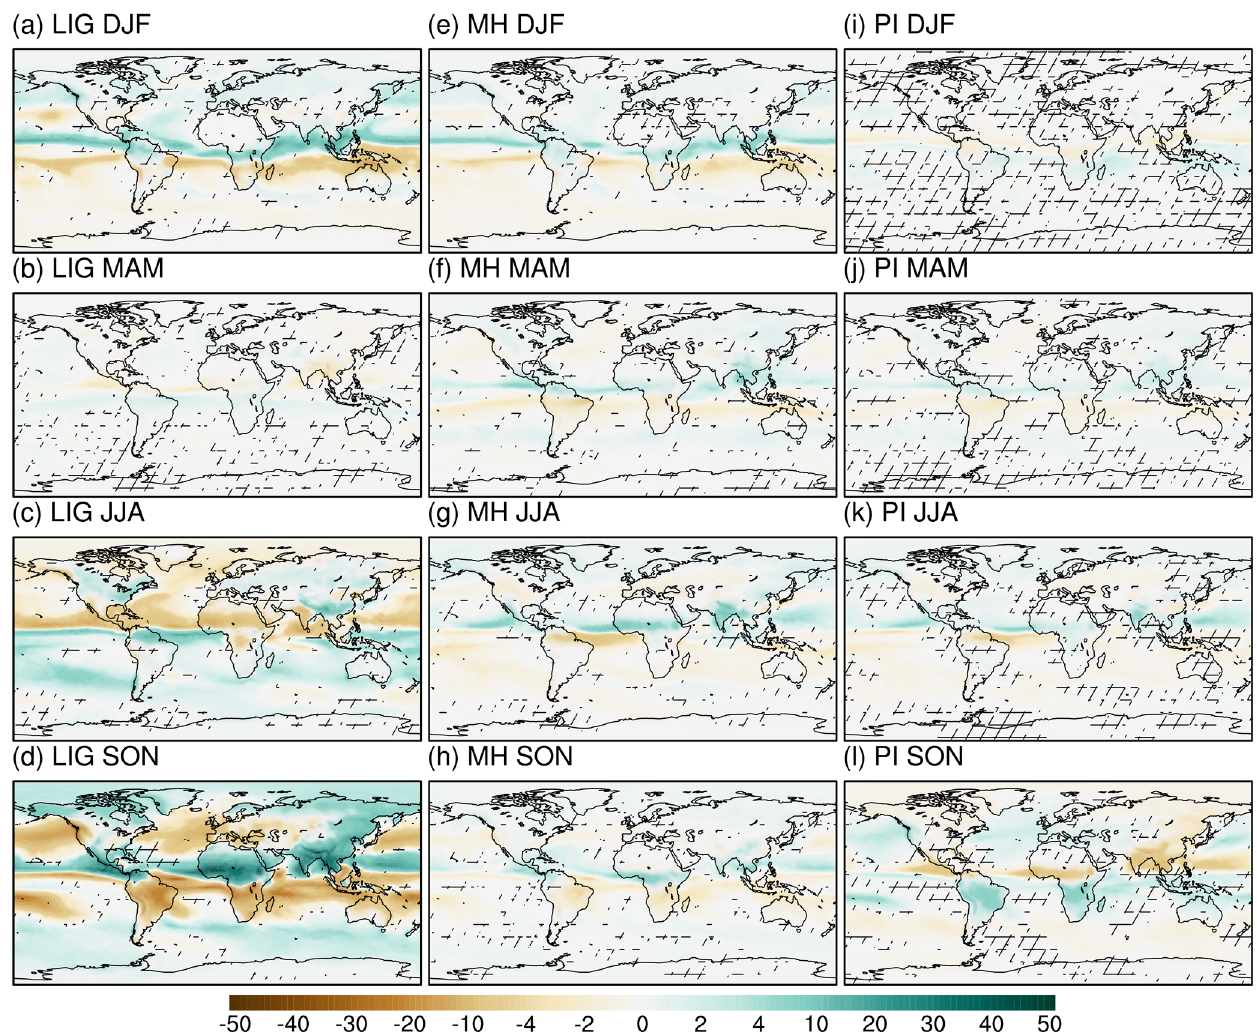
Figure 6. Ensemble anomalies of precipitation between angular and classical means for (a–d) LIG, (e–h) MH, and (i–l) PI. The unmarked area indicates that at least seven models show the same sign. Units: mm per